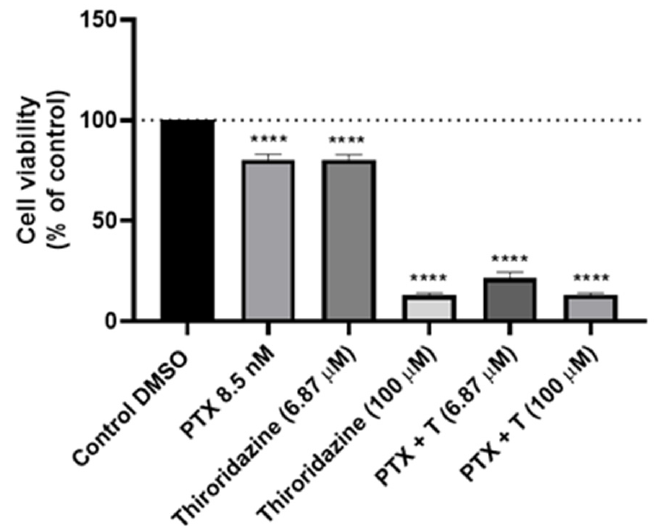
Figure 18. Effect of the single use of paclitaxel or thioridazine, and the combinations of both drugs, on the cell viability (% of control) of MCF-7 cells at 48 h. Results are expressed as mean ± standard error of the mean (SEM) and represent four independent experiments ( n = 4). **** p < 0.0001. Table 2. CI values and respective effect of the combination of paclitaxel with benztropine and thioridazine. Dose of Paclitaxel Dose of Benztropine Dose of Thioridazine